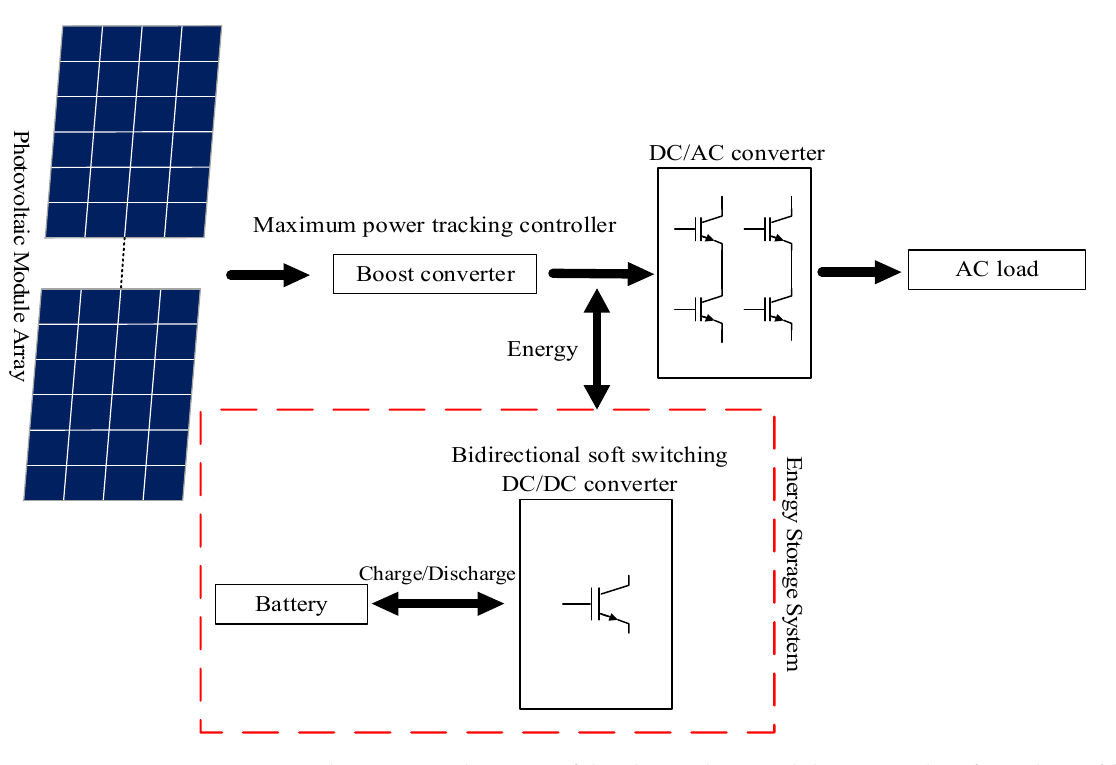
Figure 1. The system architecture of the photovoltaic module array and uniform charge/discharge control energy storage battery system.